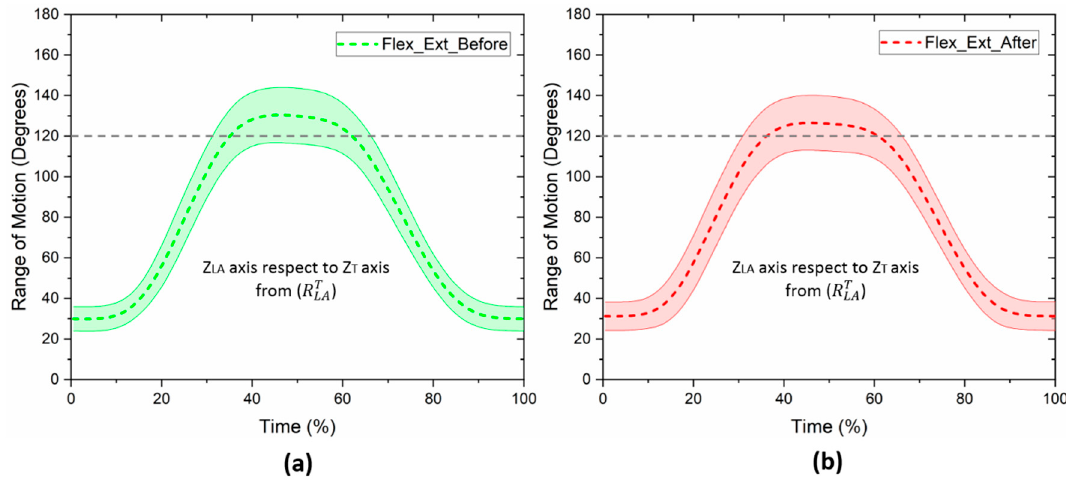
Figure 3. Mean and standard deviation of the range of motion of the glenohumeral joint, before and after breast cancer surgery: ( a ) flexion–extension before mastectomy; ( b ) flexion–extension after mastectomy. Movement of the 𝑧⃗ (cid:3013)(cid:3002) axis of the arm with respect to the 𝑍⃗ (cid:3021) axis of the torso, from 𝑅 (cid:3013)(cid:3002)(cid:3021)